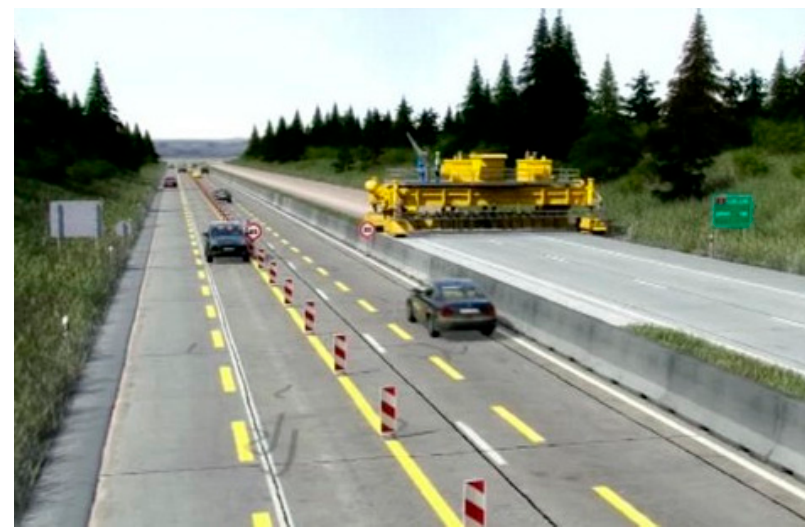
Figure 1. Illustration of a motorway work zone (source: iDnes.cz).